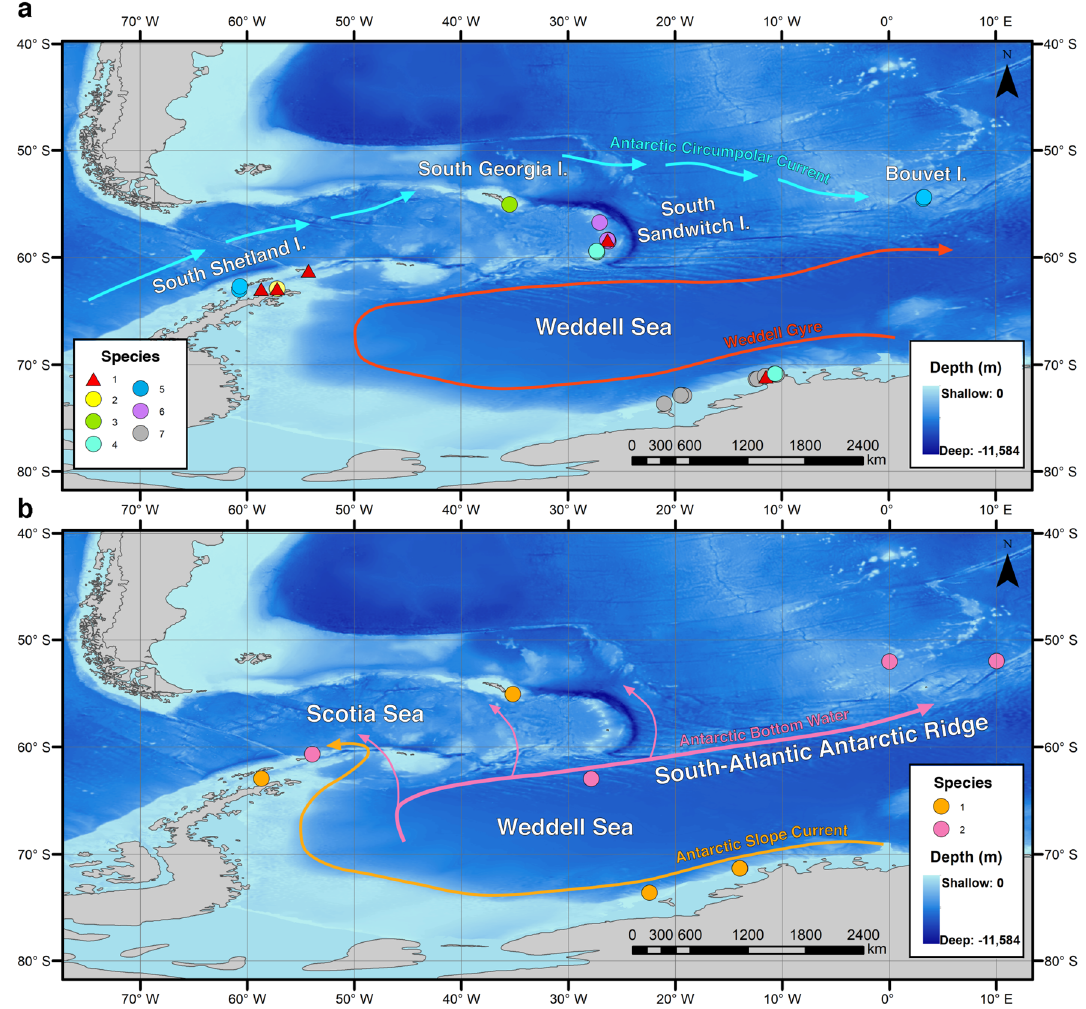
Figure 5. Bathymetric maps showing the distribution of the antarctophilinid specimens from the Atlantic sector of the Southern Ocean including the Scotia Sea, Eastern Weddell Sea, and South Atlantic. ( a ) Shallow water species: (1) Waegelea antarctica ; (2) Antarctophiline sp. 2; (3) A. gibba ; (4) A. alata ; (5) A. cf. alata ; (6) Antarctophiline sp. 3; (7) A. easmithi . ( b ) Deep-sea species: (1) A. amundseni ; (2) Antarctophiline sp.